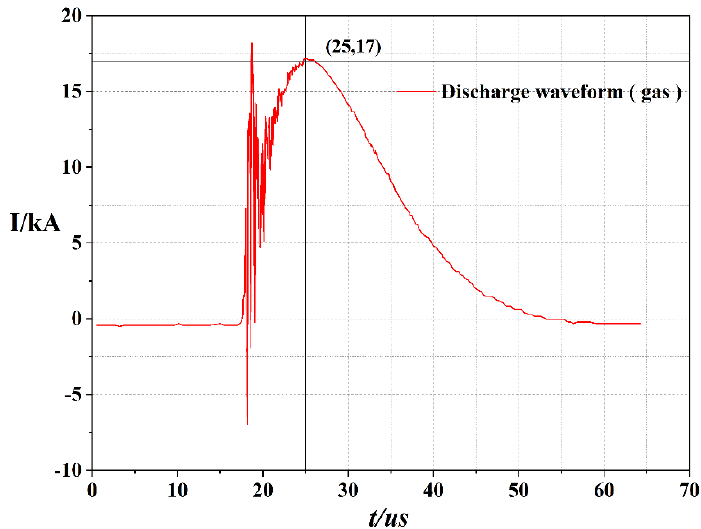
Figure 12. Arc − extinguishing waveform of the 100 mm gas gap explosion (70 kV).